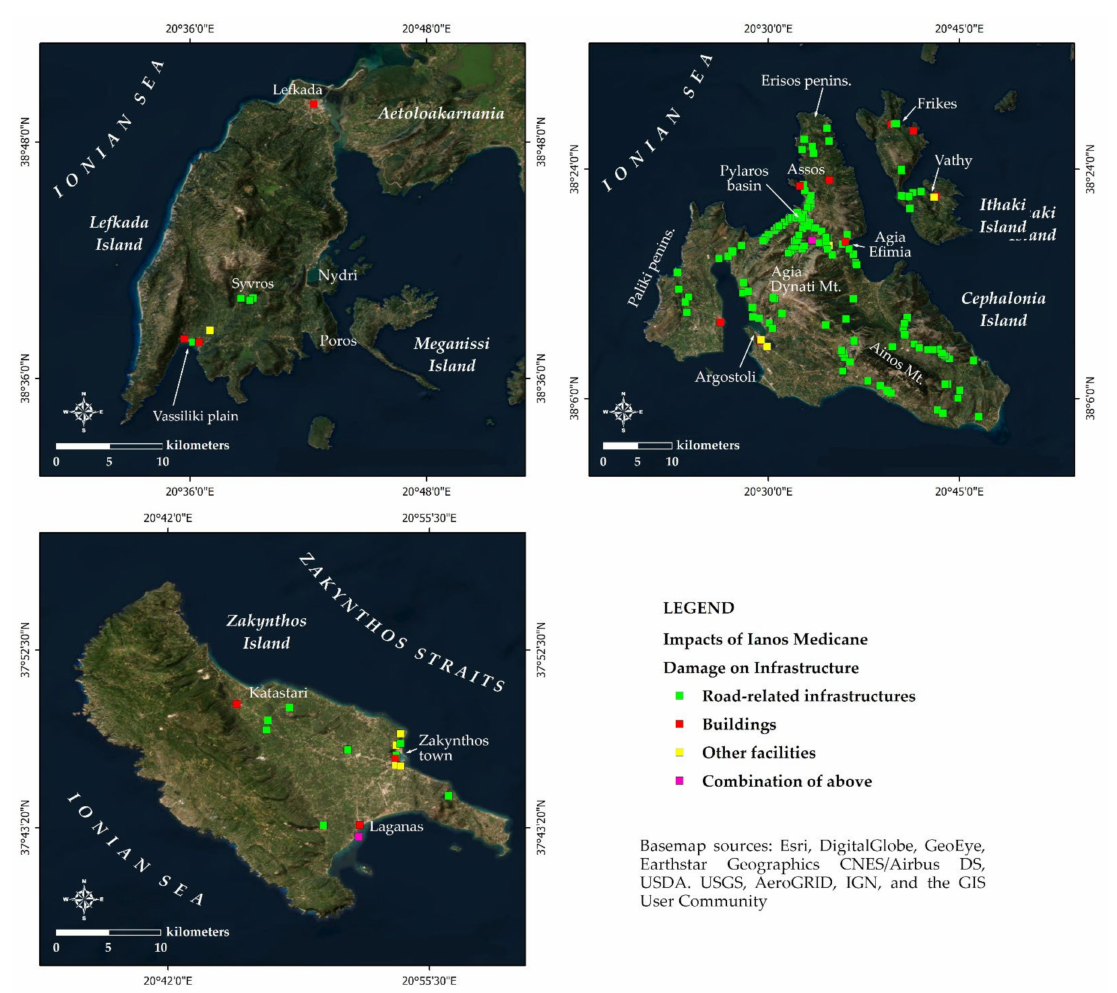
Figure 4. Map of impacts of Ianos Medicane on the built environment of Ionian Islands, including road-related infrastructure, buildings, and other facilities or a combination of